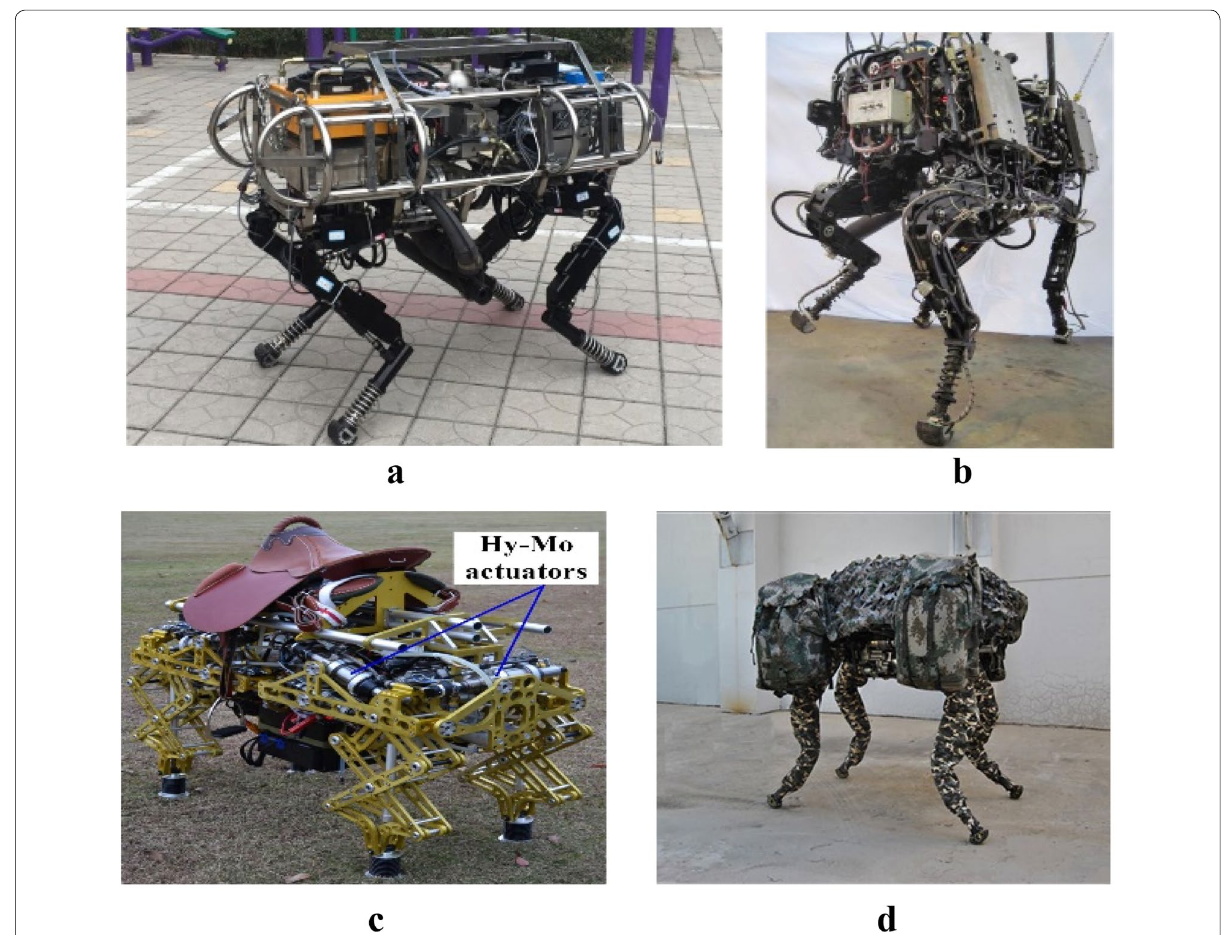
Figure 4 Hydraulic quadruped robots: a SDU SCalf-II; b HIT robot; c SJTU Baby elephant; d CNVI quadruped